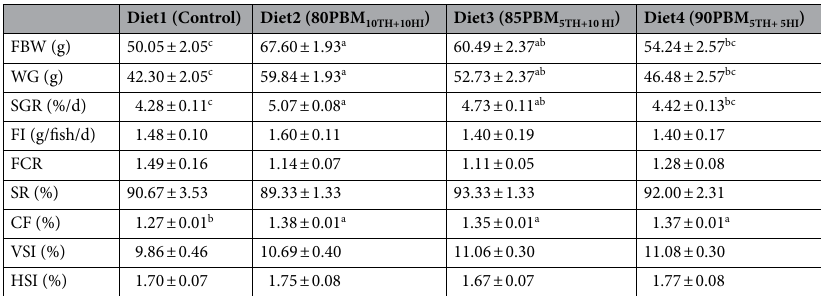
Table 4. Growth performance, feed utilization, survival and organo-somatic indices of barramundi fed Control (Diet1), 80PBM 10TH+10HI (Diet2), 85PBM 5TH+10HI (Diet3), and 90PBM 5TH+5HI (Diet4) for six weeks. Multiple comparisons were performed by one-way ANOVA analysis followed by Dunnett’s multiple comparisons test. Results are expressed as mean ± SE (standard error) (n = 3). Means with different superscripts letters in the same row indicates significant difference at P < 0.05.